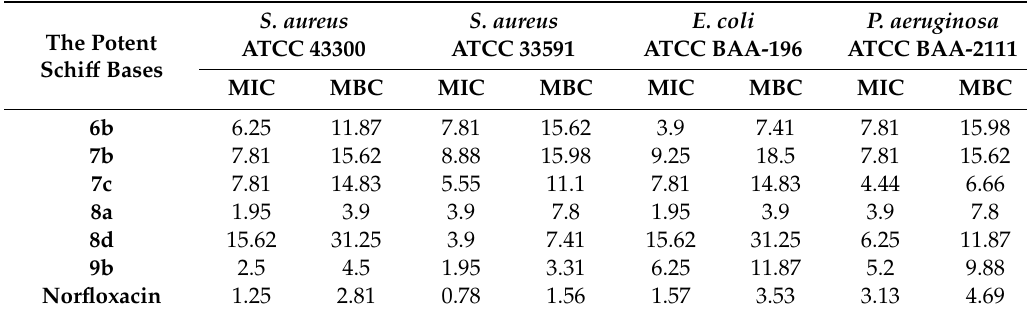
Table 7. Minimal inhibitory concentrations (MIC, µ g / mL) and minimum bactericidal concentrations (MBC, µ g / mL) of the most potent Schi ff bases against MDRB.